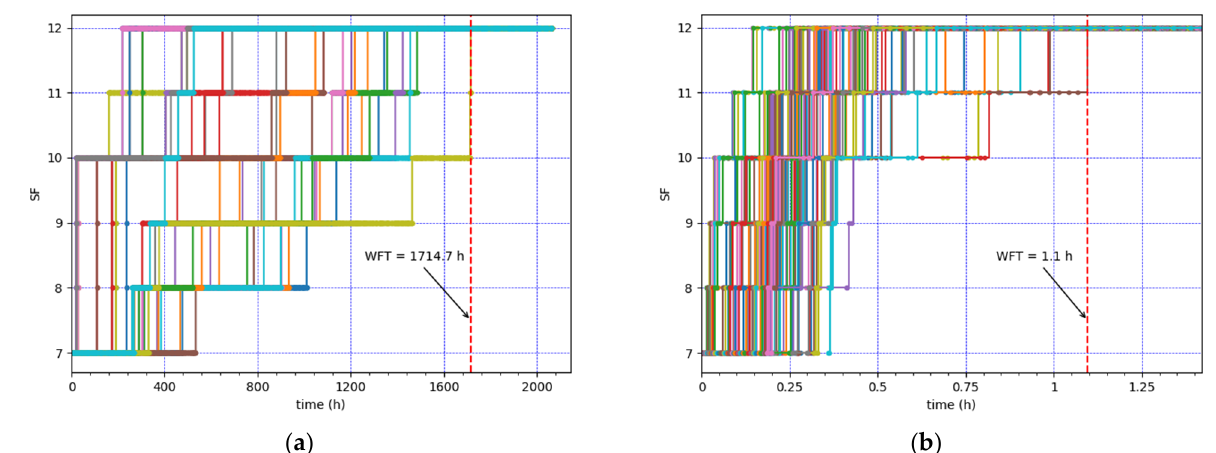
Figure 4. SF value used by each CED over time. ( a ) Lowest load: 30 CEDs, using an EDL of 0.9 packets/h. ( b ) Highest load: 100 CEDs, using an EDL of 18 packets/h.